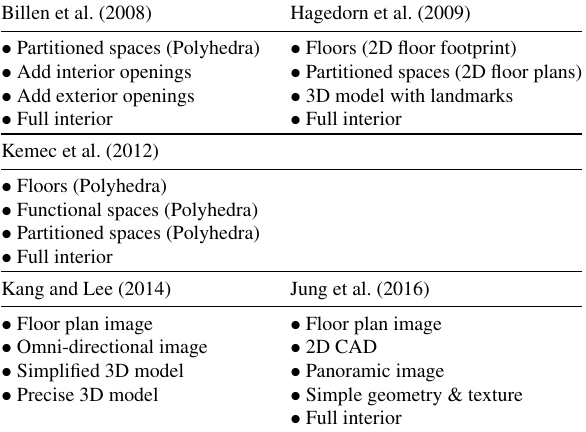
Table 3. Summary of prior proposals for indoor versions of CityGML. Indoor LODs are listed from lowest to highest.